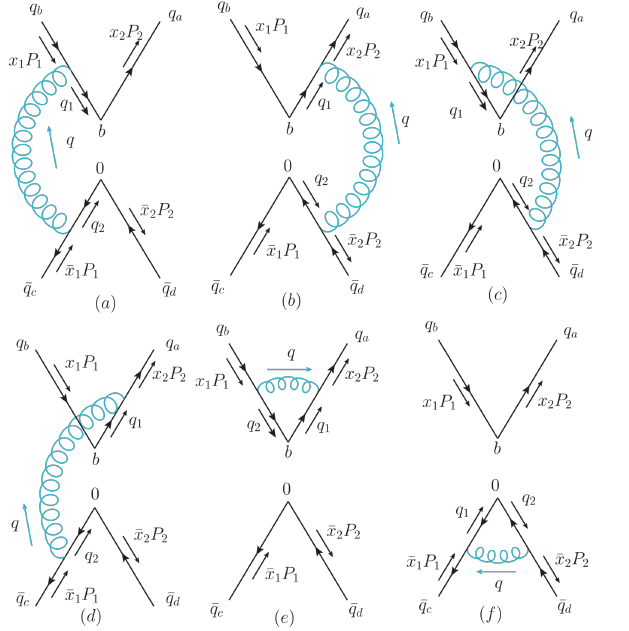
Figure 5 . One-loop Feynman diagrams to the form factor. The quark self-energy corrections are not